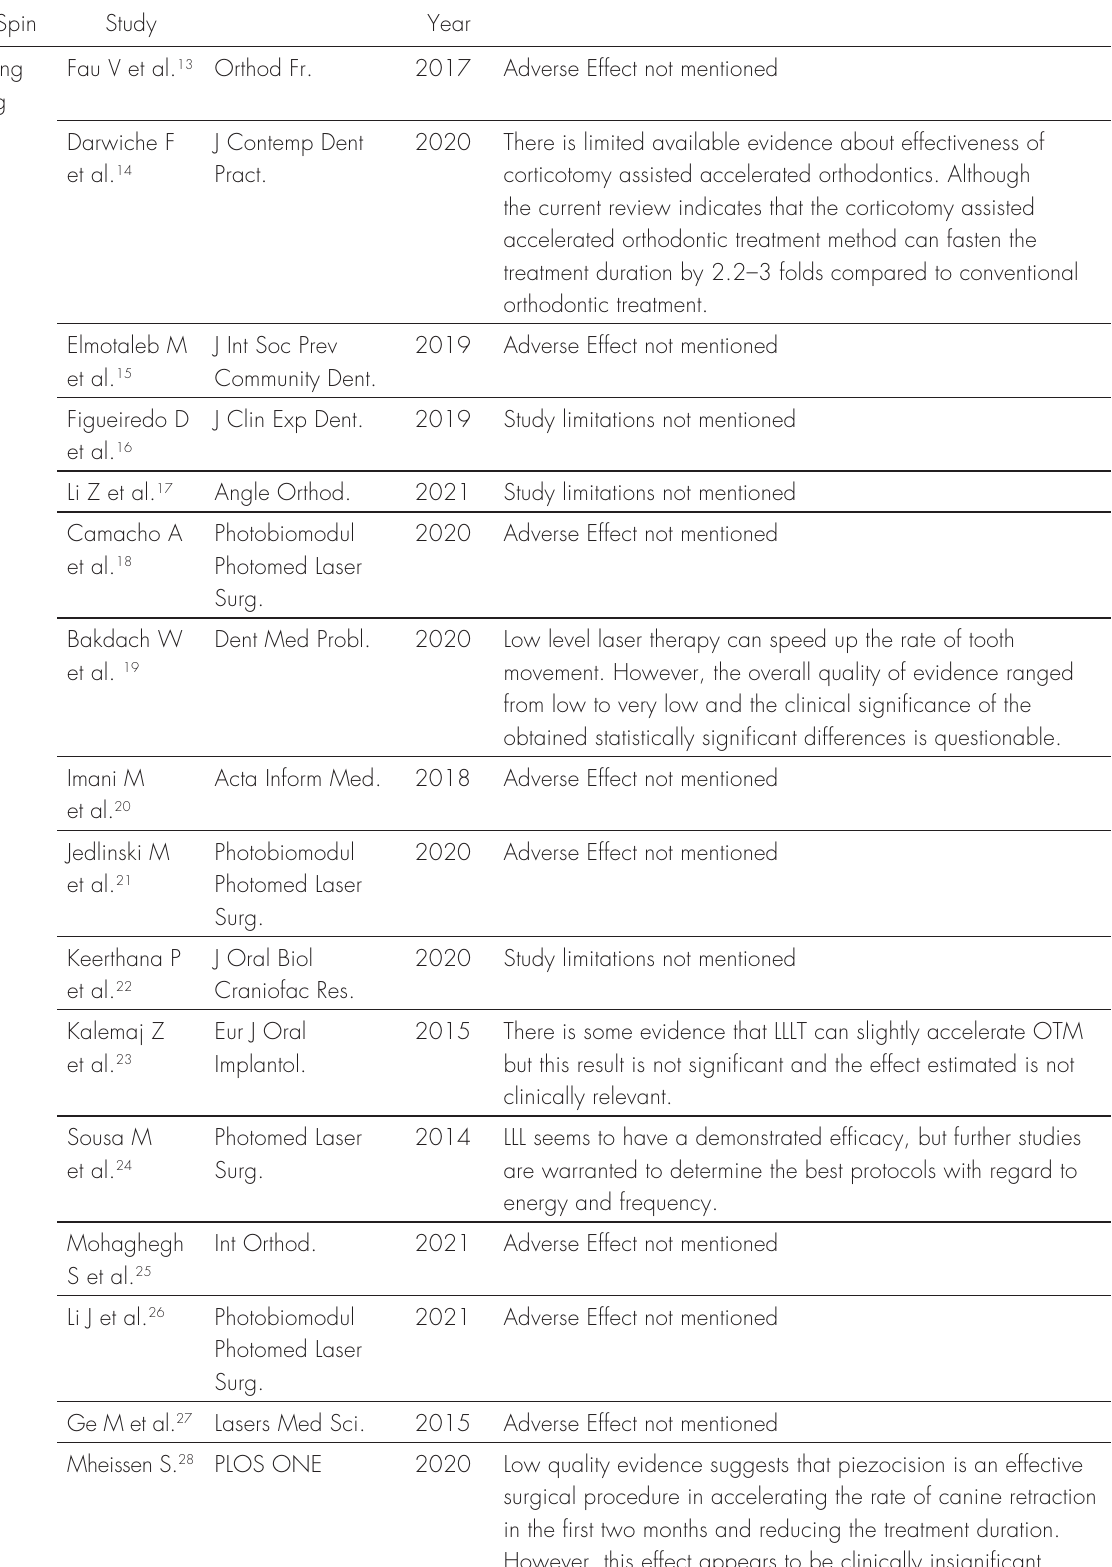
Table III. Studies having different types of spin. Type of Spin